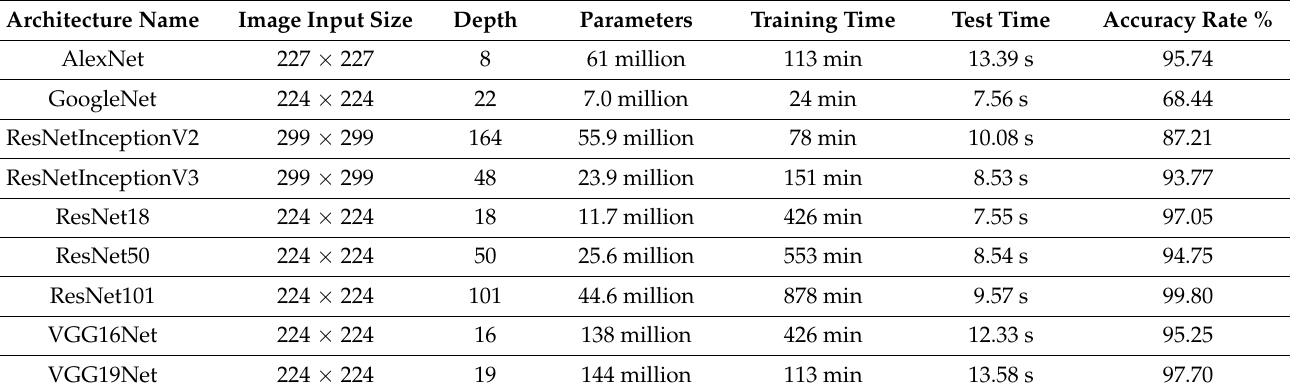
Table 1. Algorithms used in the